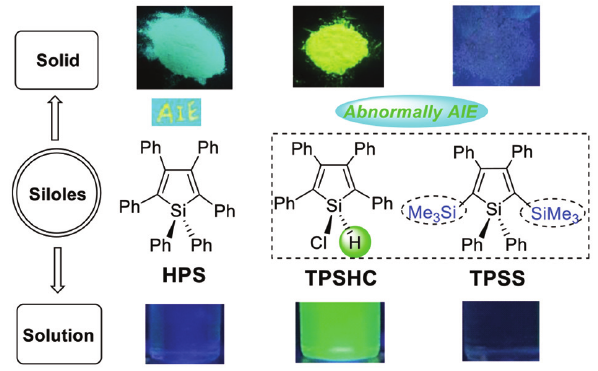
Figure 1: The luminescent spectra of the TPSHC, HPS, and TPPS in the solution state (a) and solid state